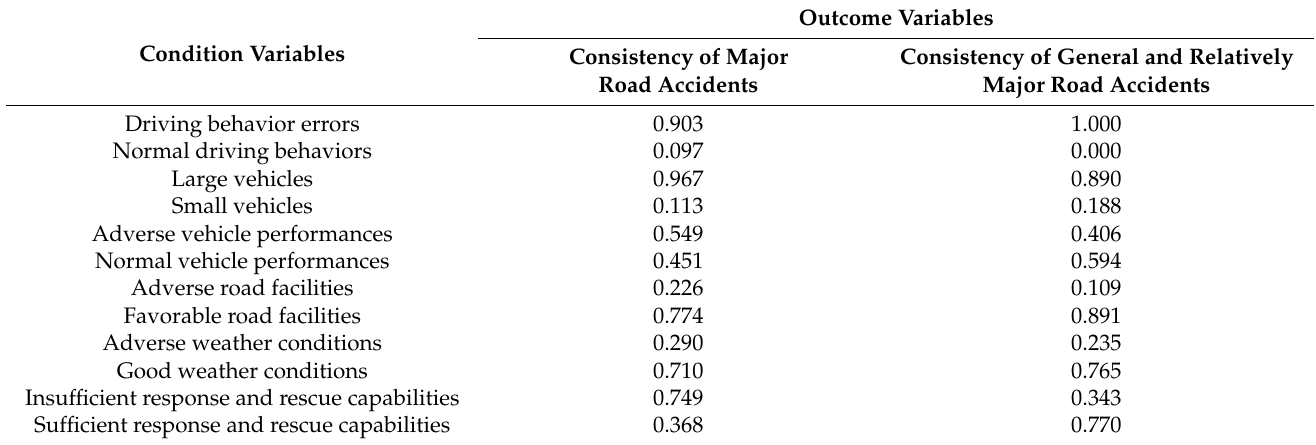
Table 2. The necessity test of a single condition based on the fsQCA